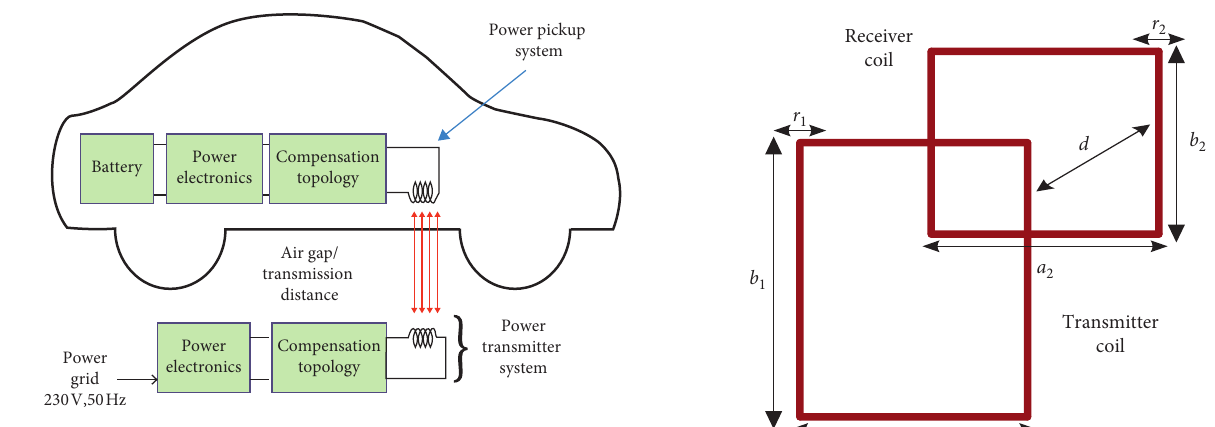
Figure 1: Configuration of the EV wireless charging